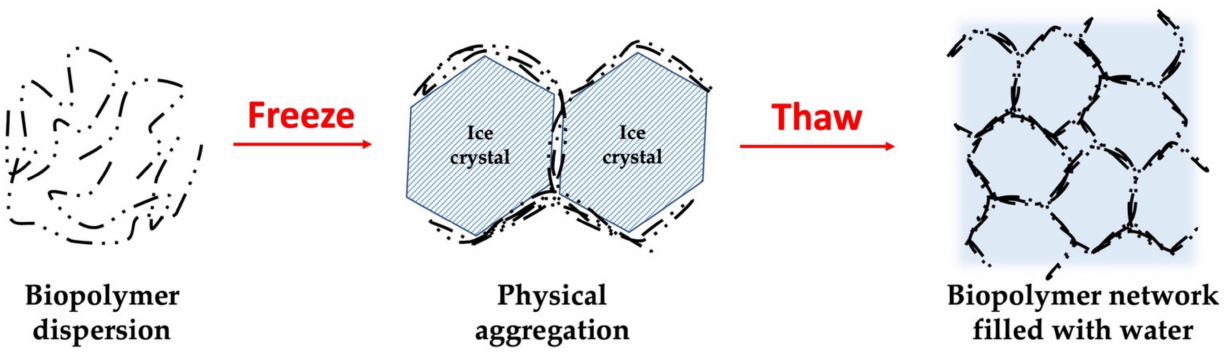
Figure 5. Schematic representation of freeze-thaw induction effect on cellulose nanocrystals hydrogel network formation